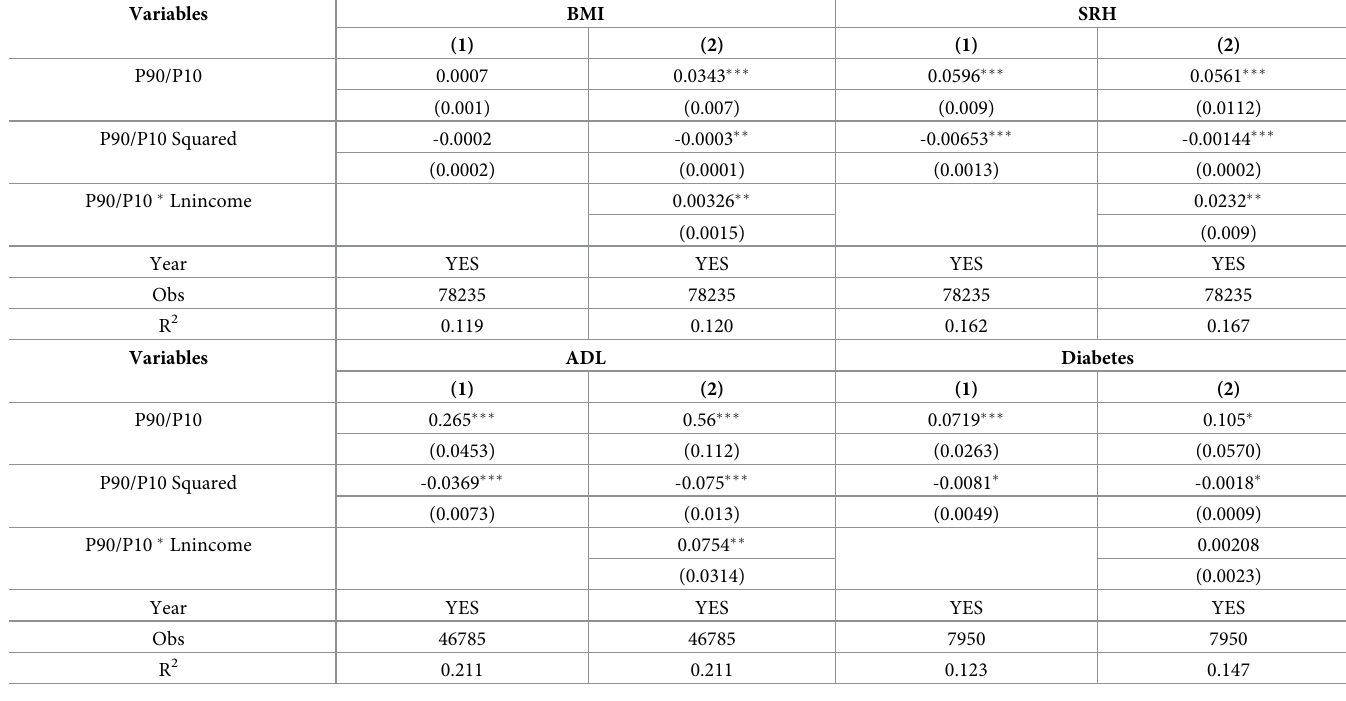
Table 12. Different